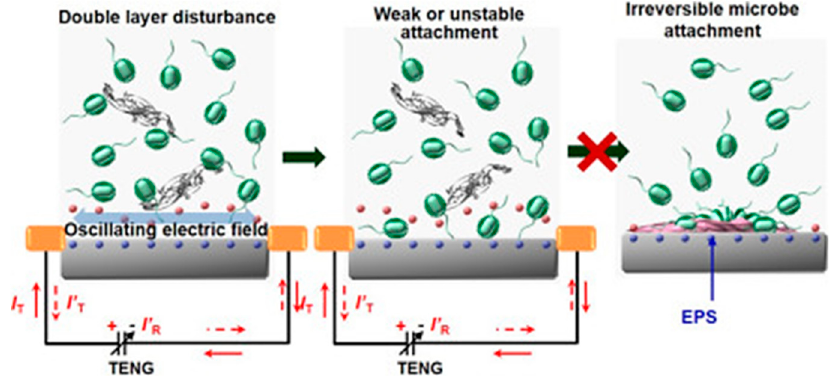
Figure 6. Schematic of a proposed anti-biofouling mechanism. Where an oscillating electric field exists, the surface double layer was disturbed leading to unstable organic and microbe attachment.